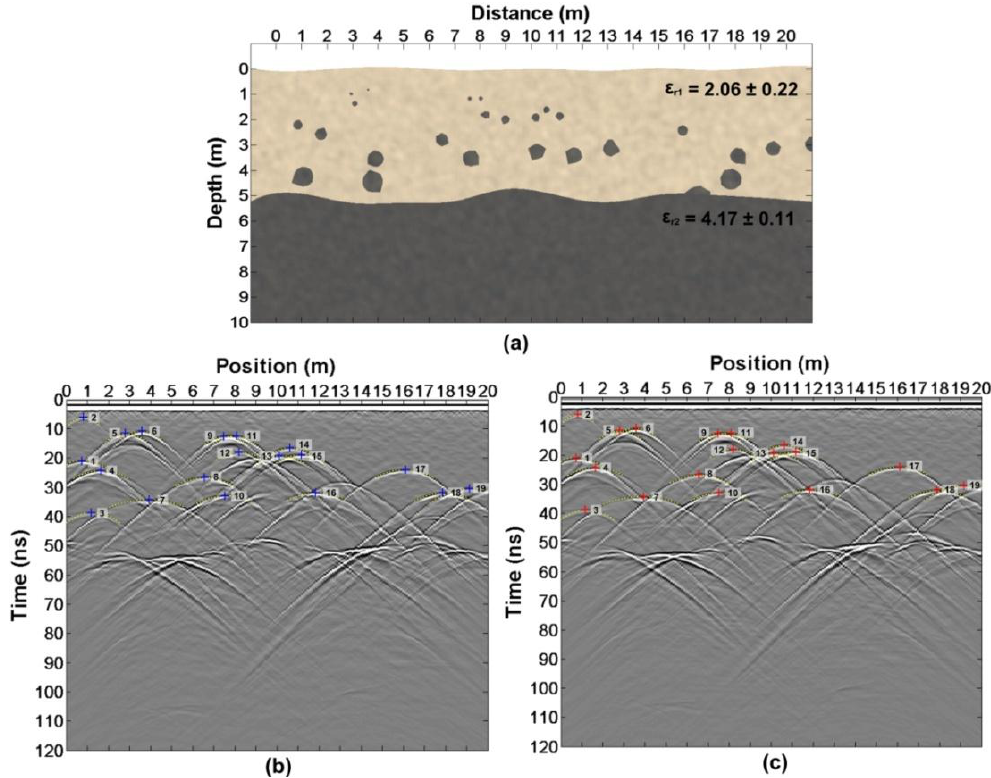
Figure 10. The height and the relative dielectric constant (Table 4) are estimated according to the Equations(13)–(16).